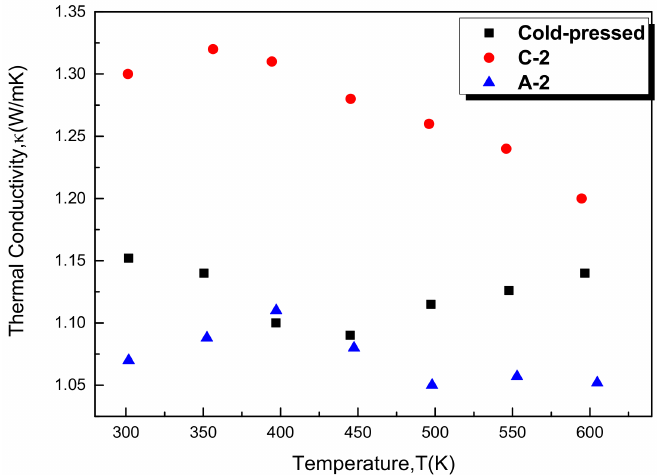
Figure 10. Variation of the power factor as a function of temperature for the hot pressed Zn 4 Sb 3 specimens.